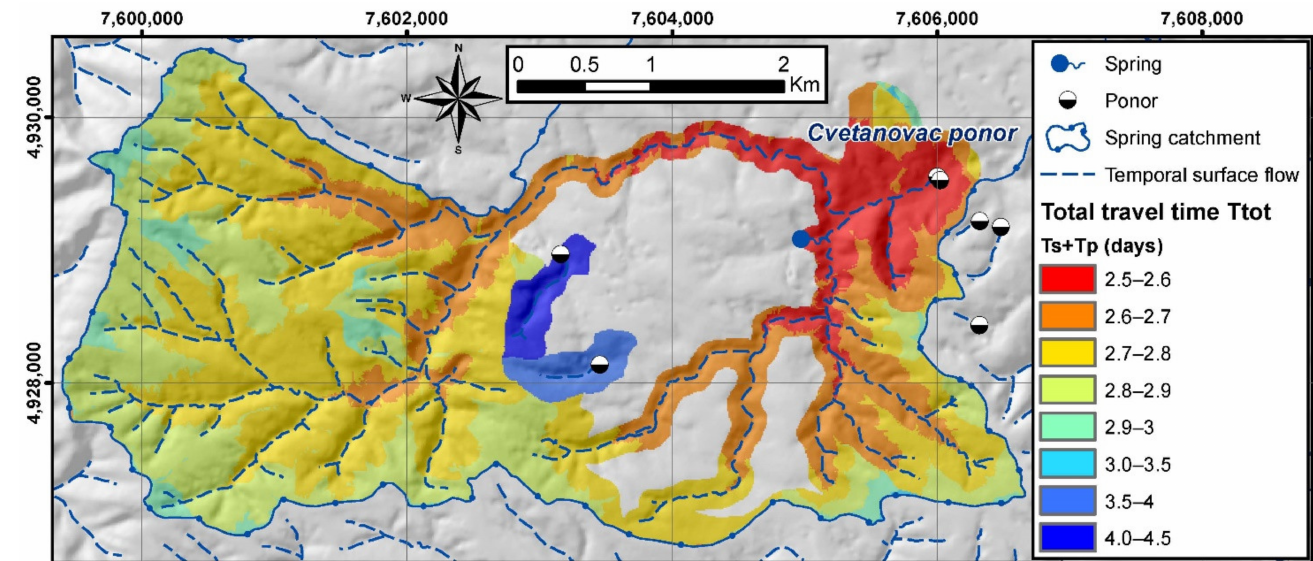
Figure 6. Vertical travel time (t v ) through the unsaturated zone.